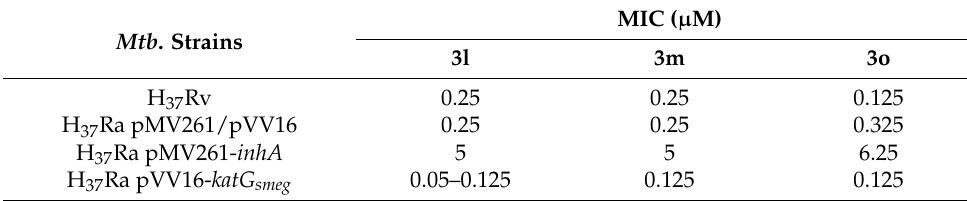
Table 4. Sensitivity testing of Mtb . H 37 Ra overproducing InhA tb or KatG smeg and H 37 Rv to the selected esters 3